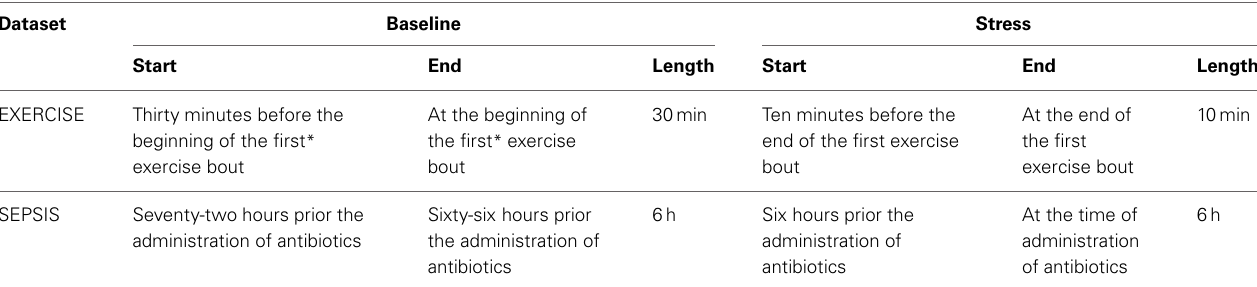
Table 2 | Segmentation of the time